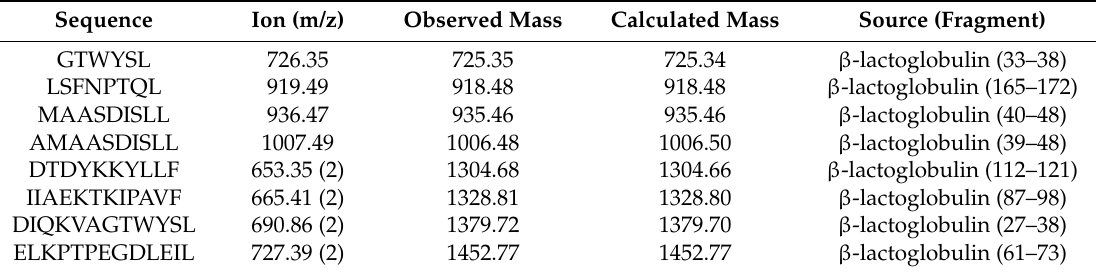
Table 3. The amino acid sequences of effective peptides from BLG-HHP-Alc hydrolysate identified by liquid chromatography with tandem mass spectrometry (LC-MS/MS), and their respective protein fragments in the BLG sequence found in the UniProt database